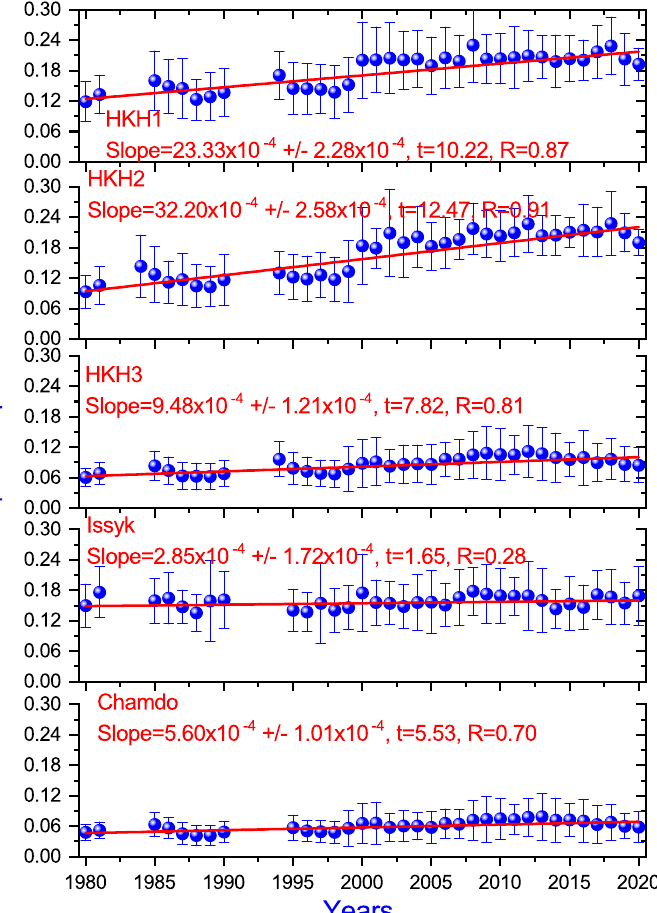
Figure 5. Yearly AOD trend at selected sites (background sites) in the HKH region using the monthly MERRA-2 data in